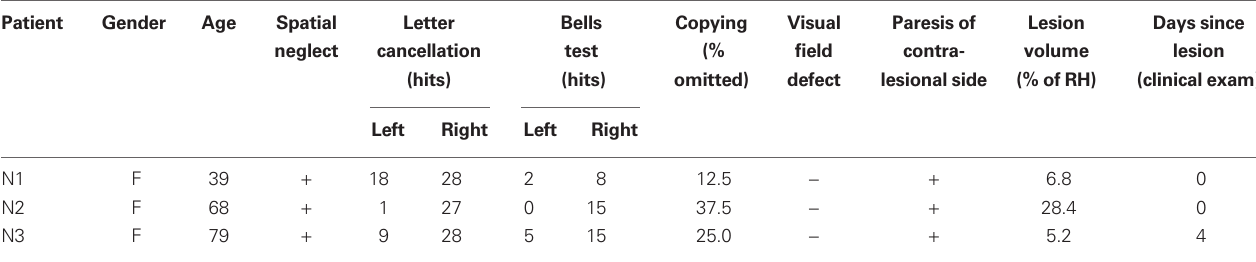
Table 1 | Demographic and clinical